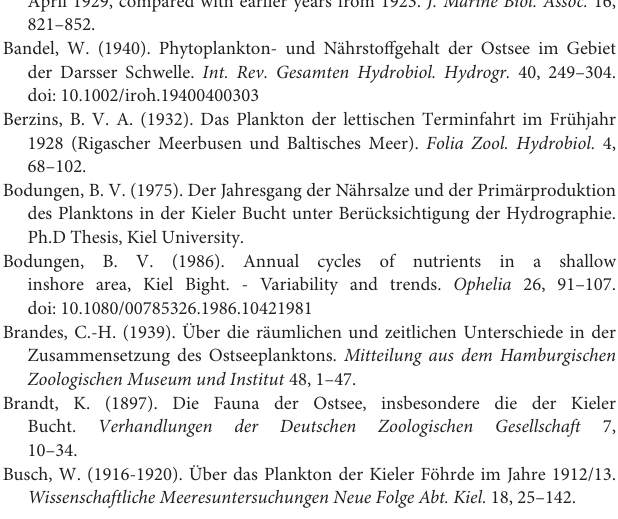
Table S1 | Compilation of historical phytoplankton data from the Baltic Sea. The references, given in the last column and numbered from 1 to 23, relate to the numbering in Figure 1 . The combined data from each spring season and sea area are shown in separate lines. The mean abundance and biomass values of diatoms and dinoflagellates are given as they provided the basis for calculations of the Dia/Dino